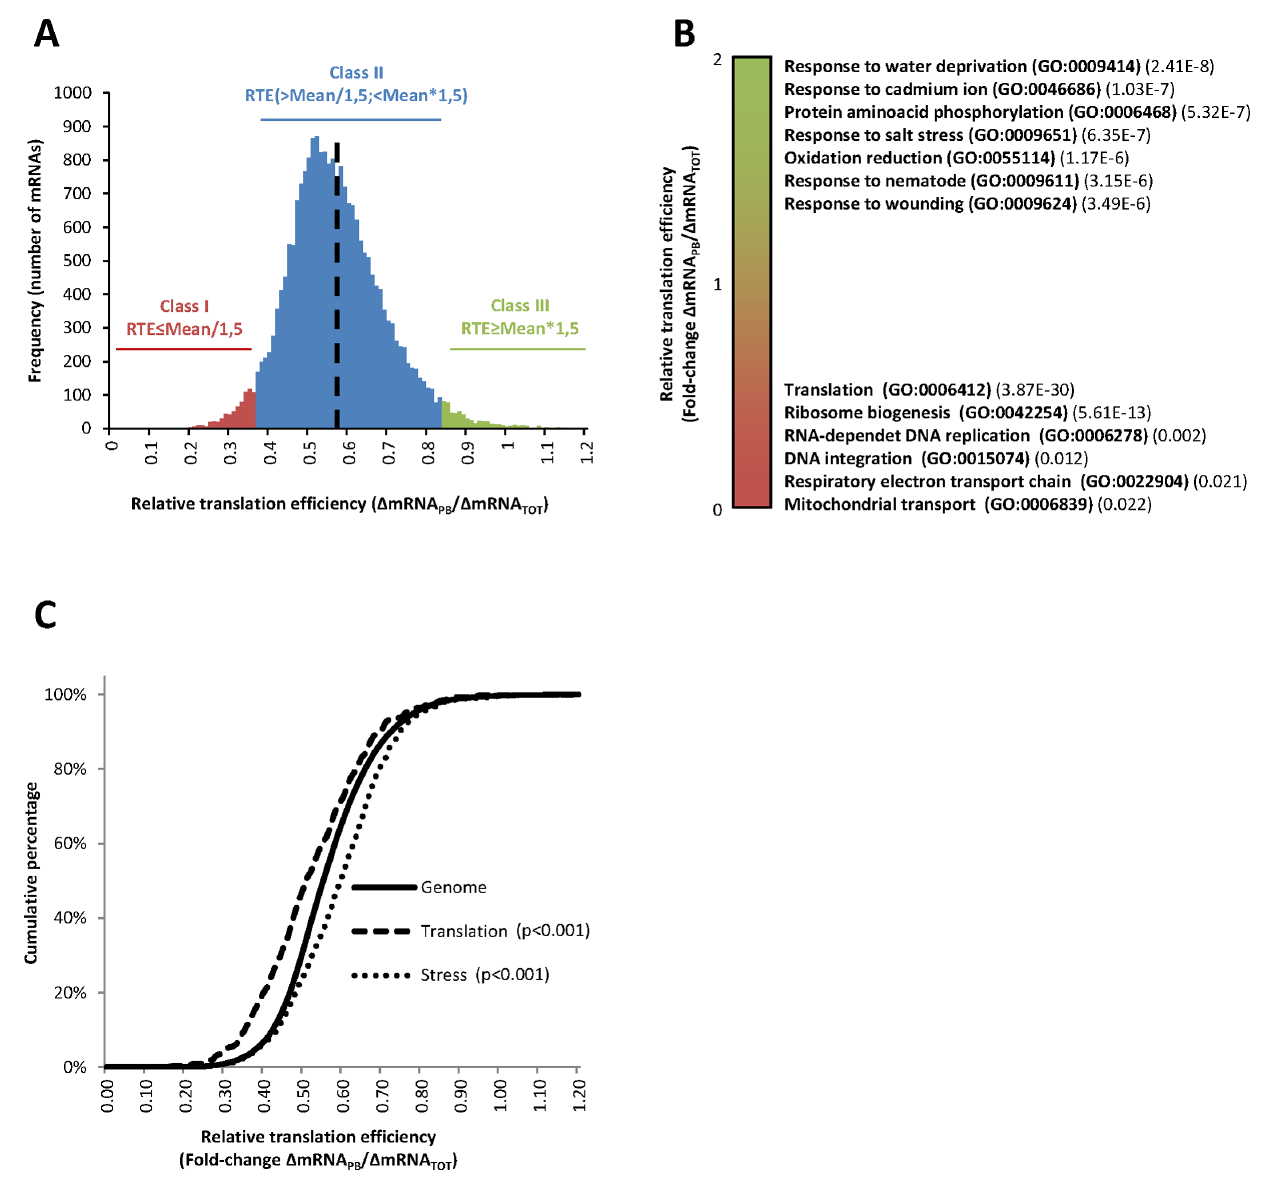
Figure 4. Heat selectively regulates translation of functionally relevant cohorts of mRNAs. ( A ) Density distribution of the relative translation efficiencies ( D mRNA PB / D mRNA TOT ) of the mRNAs selected for the bioinformatics analysis (n=16098) in response to heat-stress. The average relative translation efficiency of the distribution (0.564) is shown as a dotted black line. The categories, in which mRNAs were classified for subsequent analysis, are also shown in the figure. Class I (red; n=696) and Class III (green; n=456) included mRNAs with a relative translation efficiency # 1.5 fold or $ 1.5 fold the average translation efficiency of the distribution, respectively. Class II (blue; n=14946) included the rest of the genes within the described parameters. ( B ) Functional analysis of the selected mRNAs according to their relative translation efficiencies using FatiScan software. Translation efficiencies were graphically ranked in green ( D mRNA PB / D mRNA TOT $ 1) to red ( D mRNA PB / D mRNA TOT # 1) and the most significant GO terms enriched along the ranking were annotated on the right with the adjusted p-values. ( C ) Distribution (expressed as a cumulative percentage) of the relative translation efficiencies in response to heat stress for mRNAs in the whole Arabidopsis genome (solid line), genes related with the GO term ‘‘translation’’ (dashed line) or genes related with the GO term ‘‘stress’’ (dotted line). K–S test was used to statistically examine the variations in the distributions, using the whole genome as reference. The corresponding p-values are indicated in the figure.